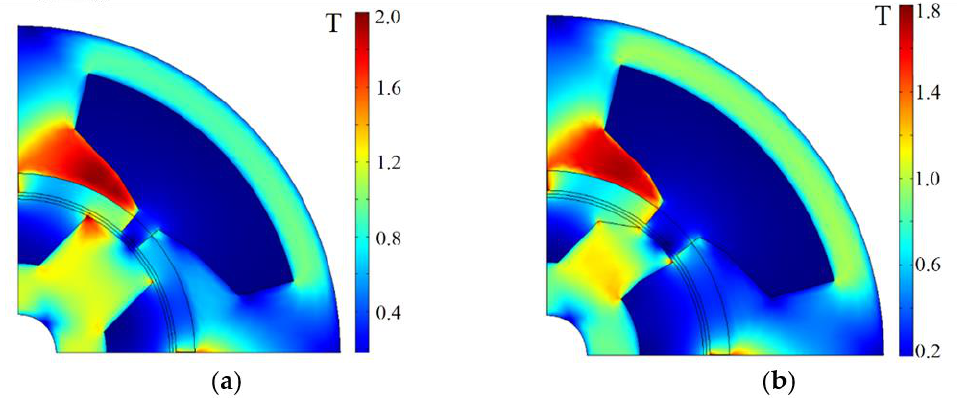
Figure 3. Motor design and simultaneous flux density field (T) in the FRM: ( a ) before optimization; ( b ) after.